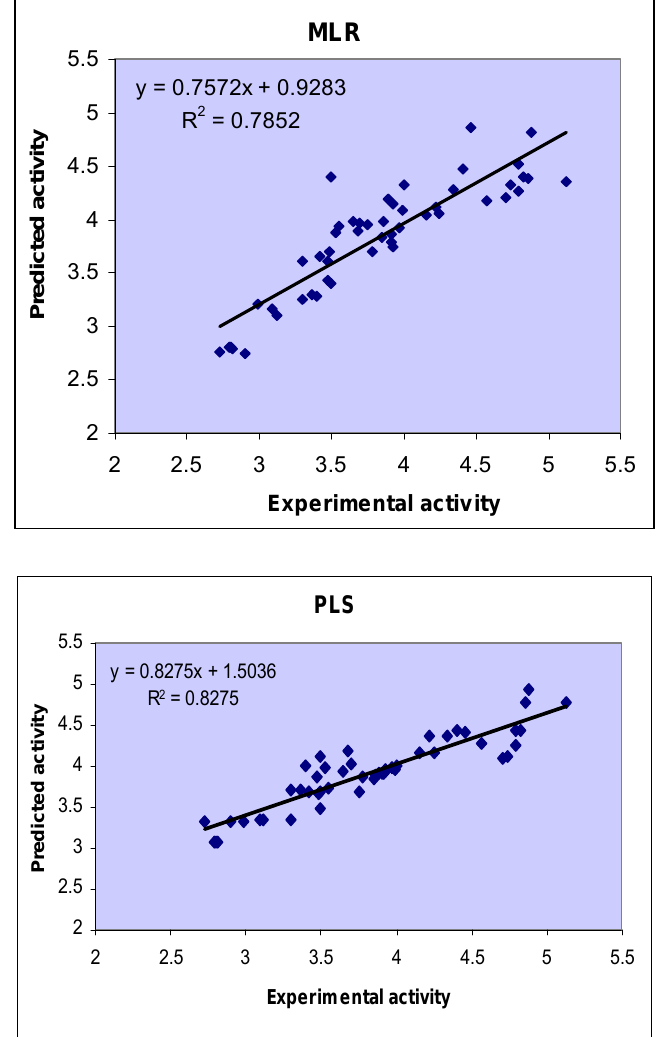
Figure 2. Plots of the cross-validated predicted activity against the experimental activity for the QSAR models obtained by MLR, GA-PLS